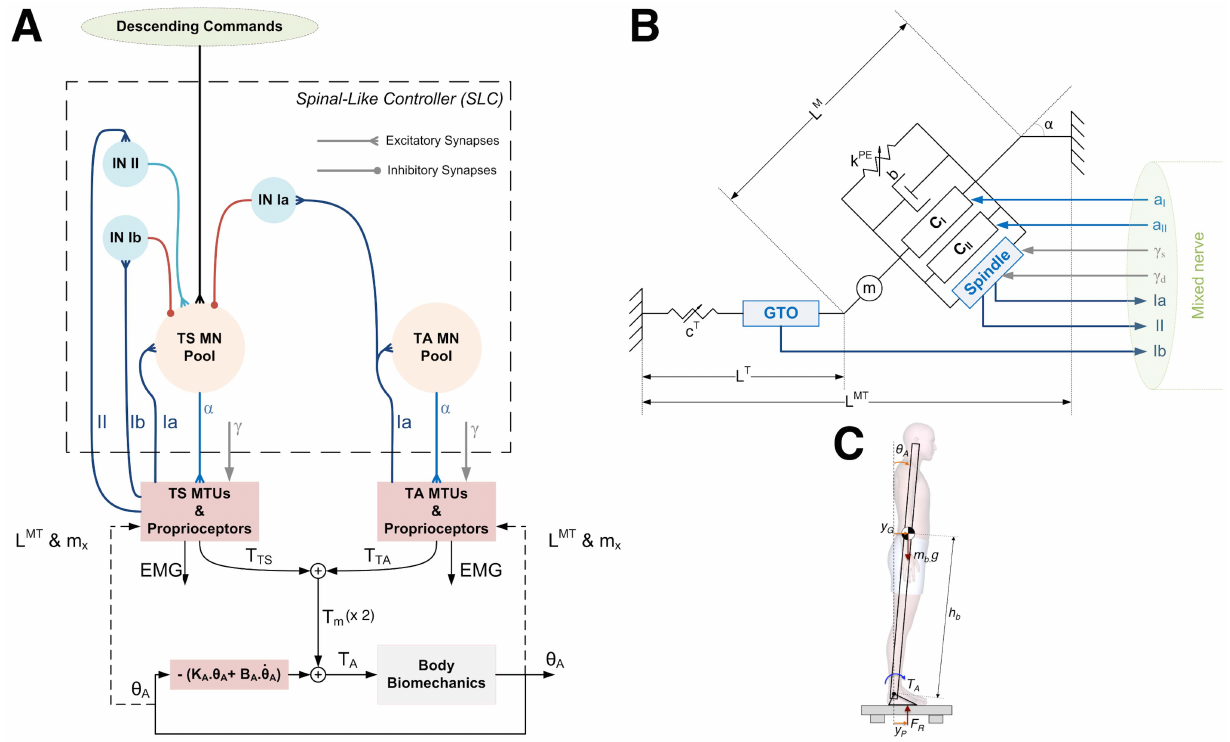
Figure 9. Overview of the postural control model. (A) Schematic view of the Spinal-Like Controller (SLC) and the biomechanics of the human upright standing. Mathematical models of spinal a motor neurons (MNs) and interneurons (INs) make up the motor nuclei associated with the Triceps Surae (TS) and Tibialis Anterior (TA) muscles. MNs from the TS motor nuclei receive constant intensity descending commands during the maintenance of upright stance. Proprioceptive feedback is provided by Ia, II and Ib afferents from muscle spindles and Golgi tendon organs (GTOs). The information carried through these afferents is fed back to the spinal cord representing fundamental pathways (or neuronal circuits) involved in the postural control task, such as Ia monosynaptic excitation, Ib di-synaptic inhibition, group II di-synaptic excitation, and reciprocal inhibition from antagonistic Ia afferents. Activity from Gamma motor neurons ( c -MNs) set the sensitivities of the muscle spindles. Ankle joint torque ( T A ) that drives the body biomechanics (to compensate for the gravitational toppling torque) is given by the sum of the torques produced by the muscles ( T m ) and the passive ankle joint torque, represented by the passive ankle joint stiffness ( K A ) and viscosity ( B A ). The body angle ( h A ) is the resultant output of the inverted pendulum acted on by gravity and by T A . It indirectly (by means of Equations 8 and 9) defines moment arms ( m x ) and musculotendon (MTU) lengths ( L MT ), which are used to define the dynamics of both MTUs and muscle receptors (see dashed lines). Additionally, h A is fed back without delay to account for the intrinsic passive joint impedance (stiffness and viscosity). (B) Hill-type model used to represent the viscoelastic and contractile properties of the MTUs. Muscle fibres are represented by parallel passive elements (muscle fibre stiffness, K PE , and viscosity, b ) and two contractile elements (CE) representing the contractile properties of type-I and type-II muscle fibres. A pinnation angle ( a ) is adopted to represent the angle between the muscle fibres and the aponeurosis. In addition, a mass ( m ) is used to increase the computational stability. Passive properties of tendon and distal aponeurosis are represented by a lumped non-linear stiffness ( c T ). Muscle spindle is placed parallel to the muscle fibres, while the GTO is in series with the tendon. (C) Inverted pendulum model used to represent the body biomechanics during the upright quiet stance. Arrows indicate the positive direction of each variable (see the description of each variable in the text).